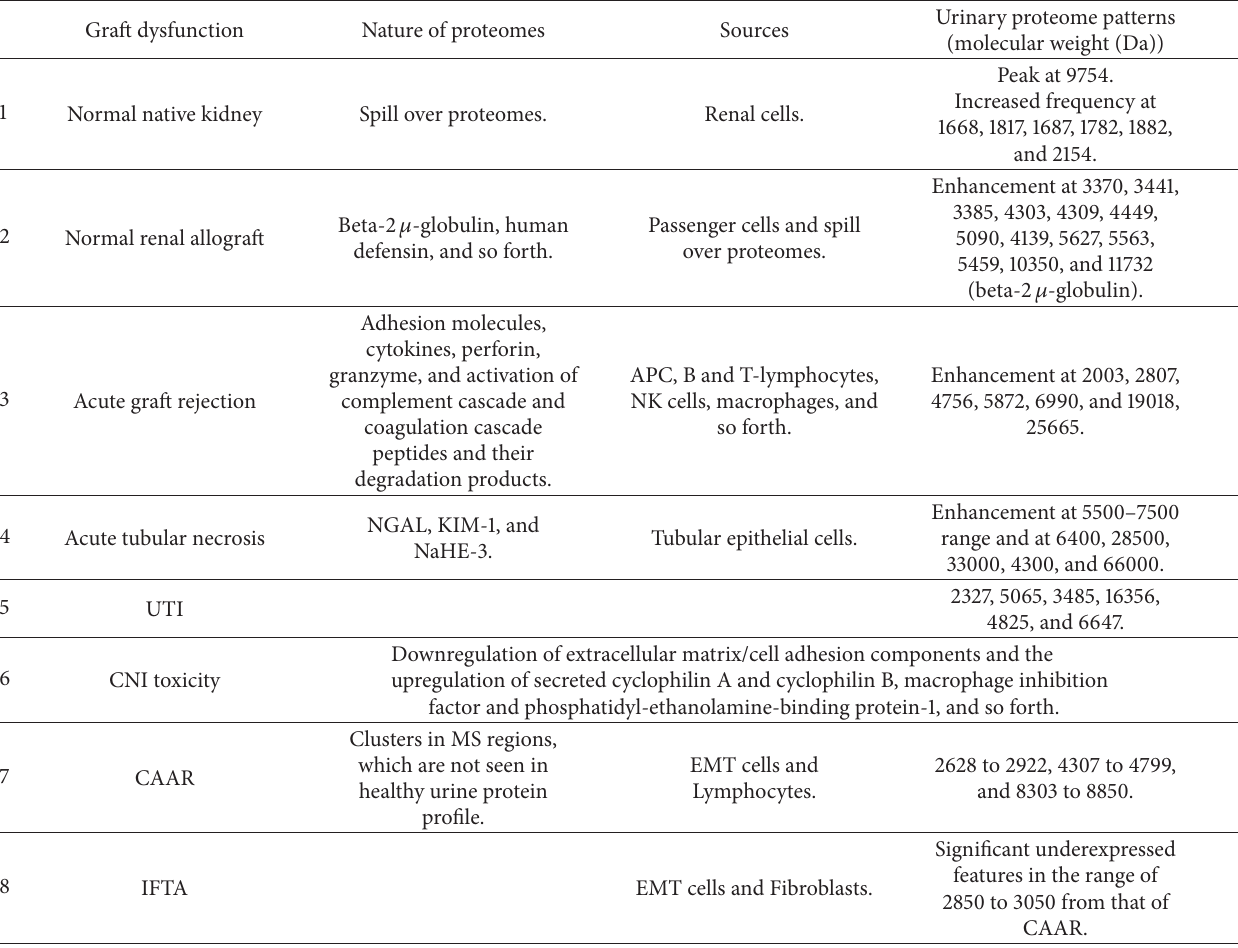
Table 2: Patterns of urinary proteome in different renal allograft